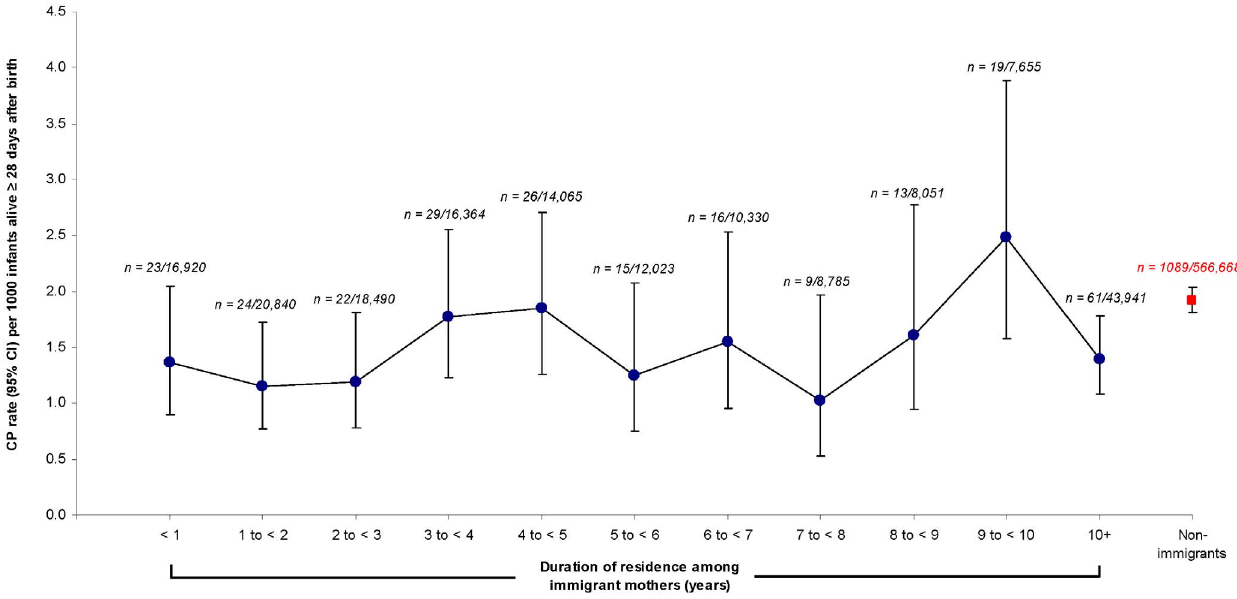
Figure 3. Unadjusted rate of cerebral palsy (CP) per 1000 singleton or twin infants, assessed from 28 days after birth up to 4 years of age. Data are shown according to duration of residence among immigrant mothers (black dots) and also among non-immigrant mothers (red square). The number of cases of CP cases over the number of infants are shown for each interval (e.g., ‘‘n=23/16,920’’ ).